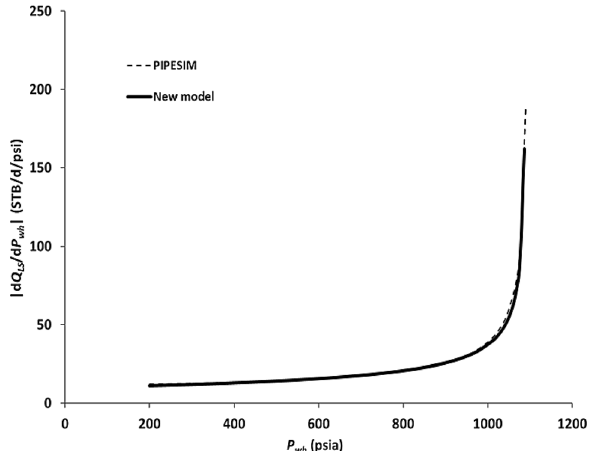
Fig. 10 Stability plots for well C